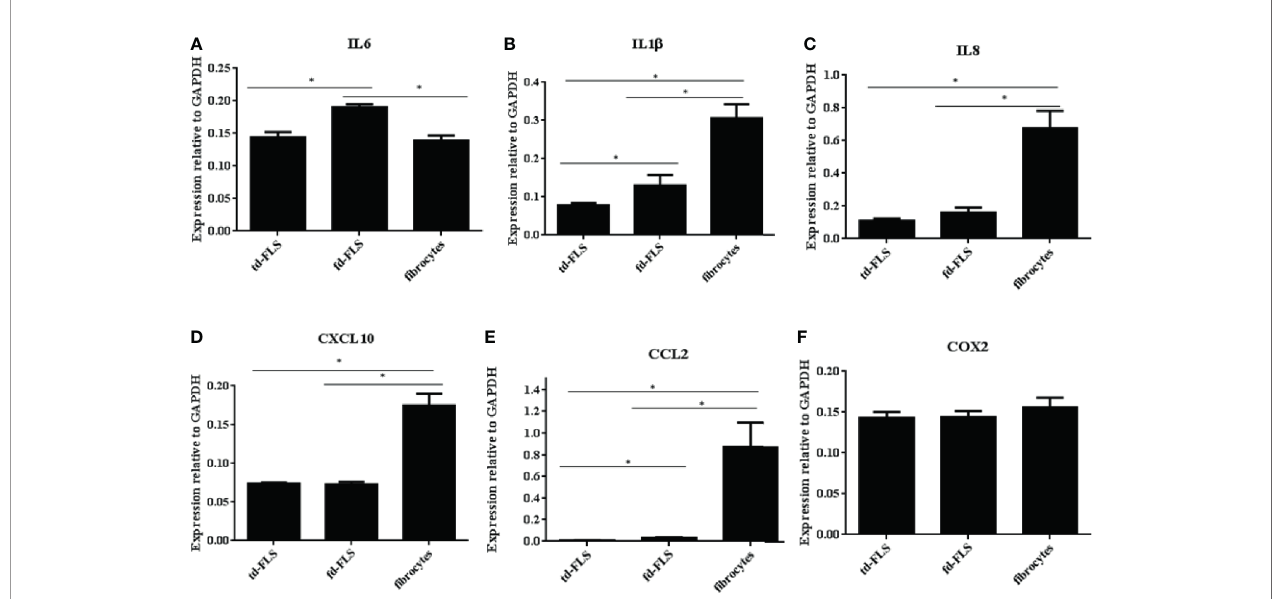
FIGURE 5 | Expression of Wnt5a pro-in fl ammatory targets in td-FLS, fd-FLS and fi brocytes during RA. IL6 was highly expressed in fd-FLS compared to td-FLS and fi brocytes (A) . IL1 b and CCL2 were expressed by the three cell types (B, E) . The higher mRNA levels for IL1 b and CCL2 were found in fi brocytes followed by fd- FLS. IL8 and CXL10 expression pro fi les were greater in fi brocytes than in td-FLS or fd-FLS (C, D) . Relative mRNA levels of COX2 in the three cell types (F) : No difference was detected between the cells using qPCR analysis (n=3-4). Results are shown as the mean ± SD.*Statistically signi fi cant difference p < 0.05 using non-parametric Kruskal Wallis test with a post hoc